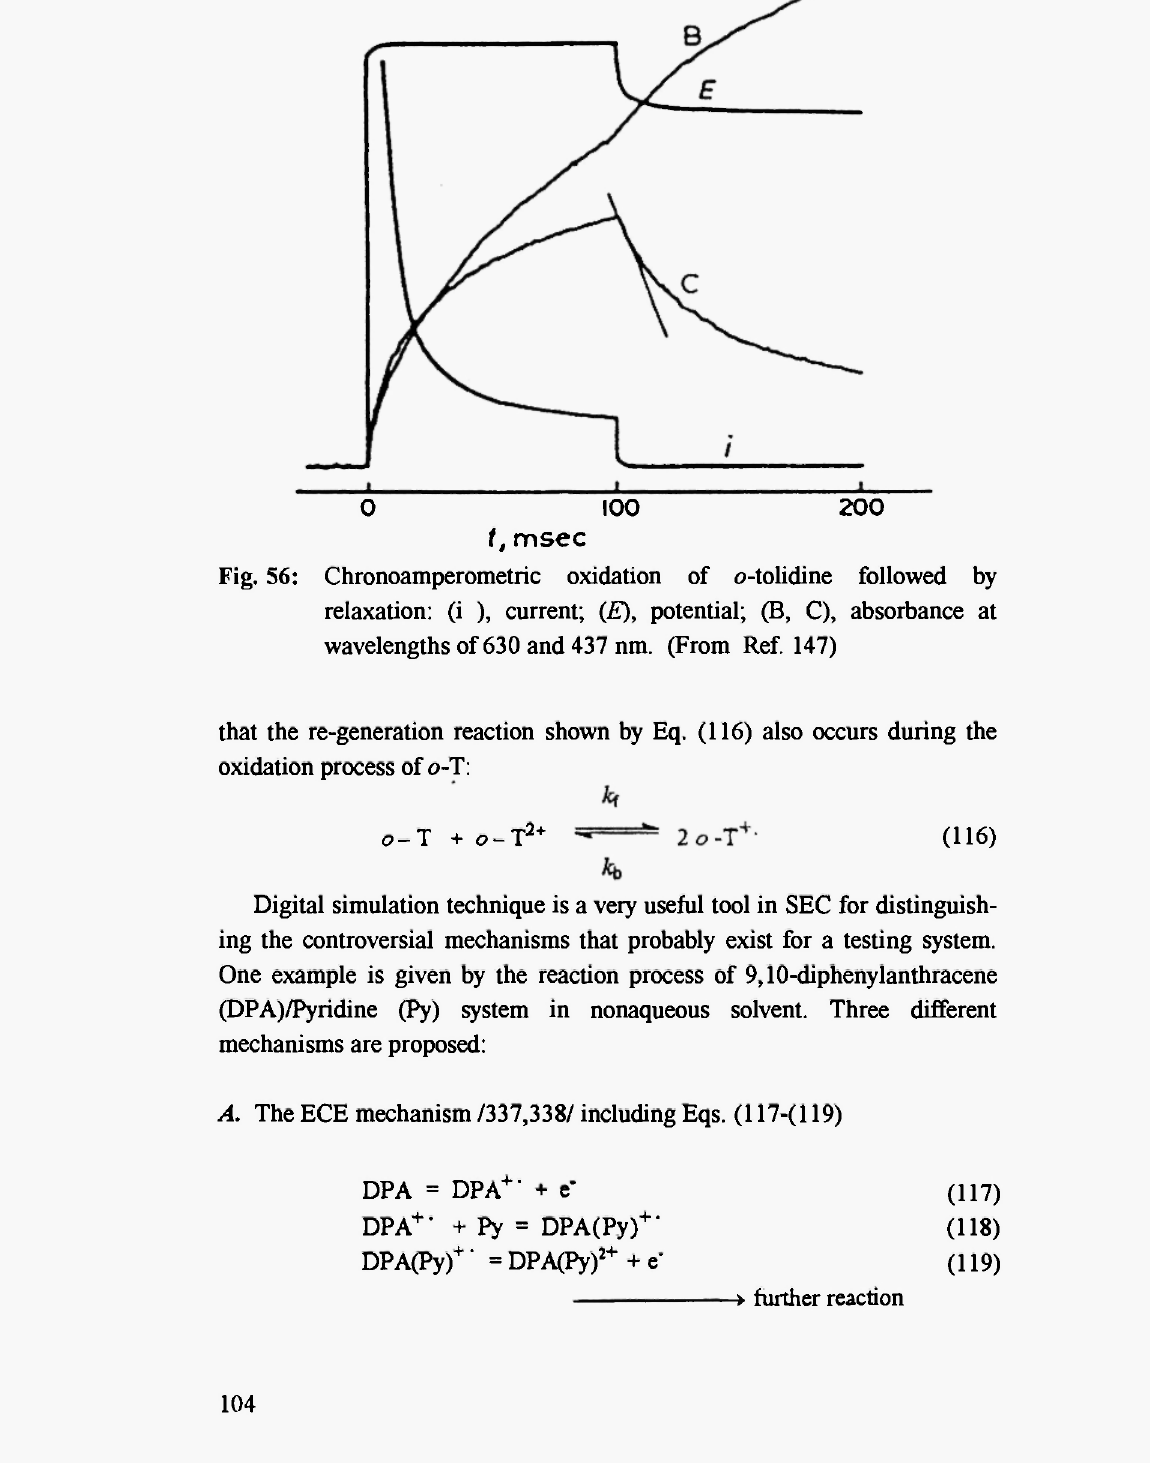
Fig. 56: Chronoamperometric oxidation of o-tolidine followed by relaxation: (i ), current; (£), potential; (B, C), absorbance at wavelengths of 630 and 437 nm. (From Ref.